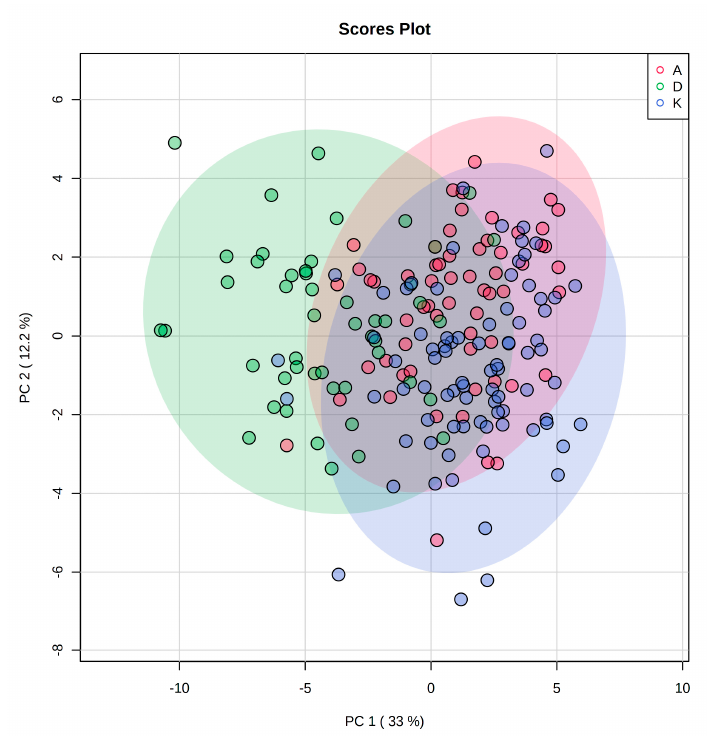
Figure 1. Clustering of sample groups in PCA based on data generated by LC-HRMS analysis of plasma sample sets (ANOVA-significant lipids only). Table 1. Significant (VIP) lipids obtained by PLS-DA model on the set of all detected plasma